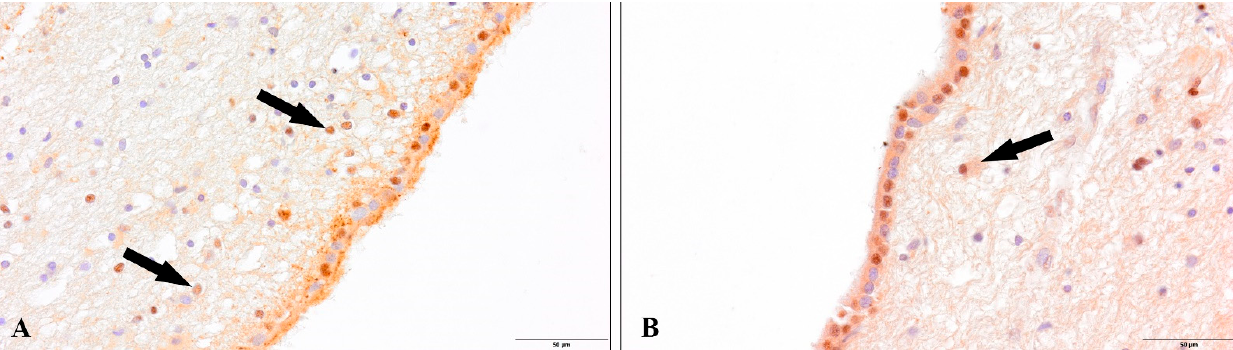
. Figure 6. Subventricular zone, newborn neurons (arrows). ( A ). Control group. ( B ). Group patients with diagnosed COVID-19. Immunolabeling NeuN antibody. To mechanistically dissect the reasons for the decreased density of neuronal progen- itor cells, we performed labeling with LCA antibodies. We observed the presence of active, ramified microglia in the hippocampal dentate gyrus (Figure 7) and subventricular zone (Figure 8) only in the group of patients with diagnosed COVID-19.